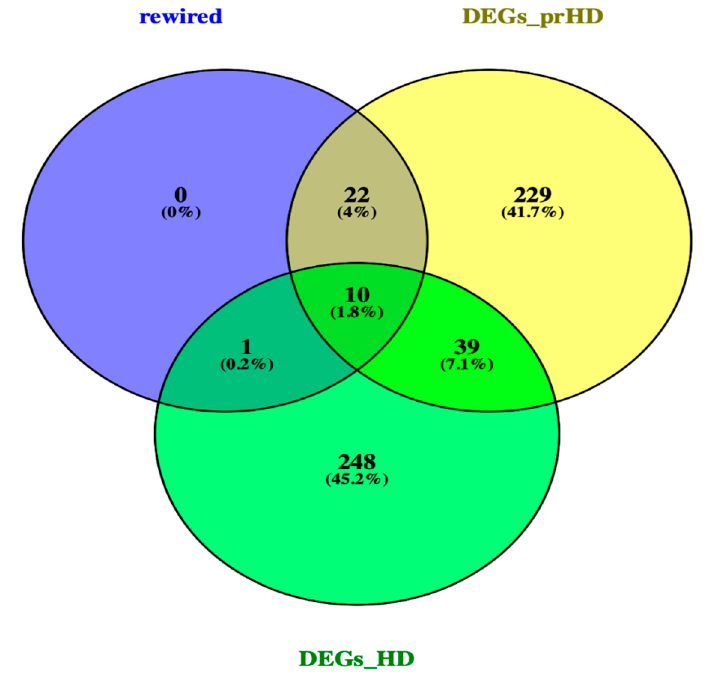
Figure 3. Venn diagram of rewired genes and DEGs of pre-symptomatic and symptomatic HD. Venn diagram illustrates the number of common genes between the rewired genes and DEGs of the two HD stages.